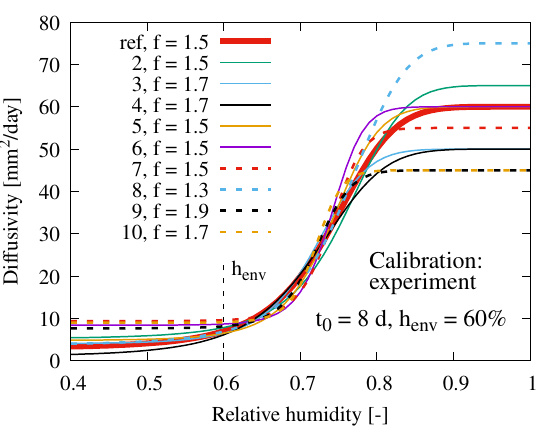
Figure 1. Best fits of axial shrinkage measured by Bryant and Vadhanavikkit [3] on 150 mm thick slabs, t 0 = 8 days, h env = 60%.